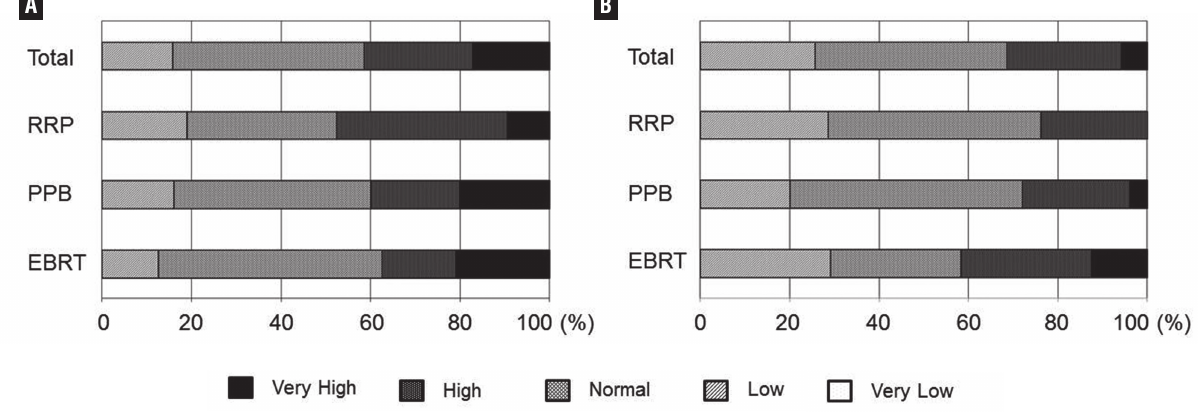
figure 1 - State anxiety and trait anxiety in patients who received radical treatments for localized PCa are shown in a and b, respectively. Twenty-nine of the 70 patients (41.4%) had very high or high state anxiety. The degree of state anxiety in patients who received RRP was highest among the 3 groups, while that of trait anxiety was